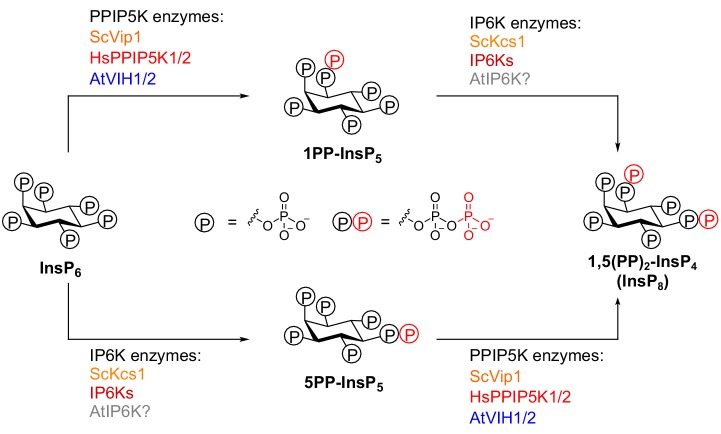
Overview of PP-InsP isoforms and kinases involved in inositol pyrophosphate metabolism.Two classes of inositol pyrophosphate kinases, PPIP5K and IP6K, are responsible for the synthesis of inositol pyrophosphates. The scheme outlines PPIP5K enzymes from Saccharomyces cerevisiae ScVip1, Homo sapiens HsPPIP5K11 and 2, and Arabidopsis thaliana VIH1 and VIH2. These enzymes synthesize 1PP-InsP5 and 1,5(PP)2-InsP4 (InsP8) by phosphorylating InsP6and 5PP-InsP5 at the C1 position, respectively. IP6K enzymes from Saccharomyces cerevisiae KCS1 and Homo sapiens IP6Ks synthesize 5PP-InsP5 and 1,5(PP)2-InsP4 (InsP8) by phosphorylating InsP6and1PP-InsP5 at the C5 position, respectively. Plant IP6Ks have not been reported thus far.